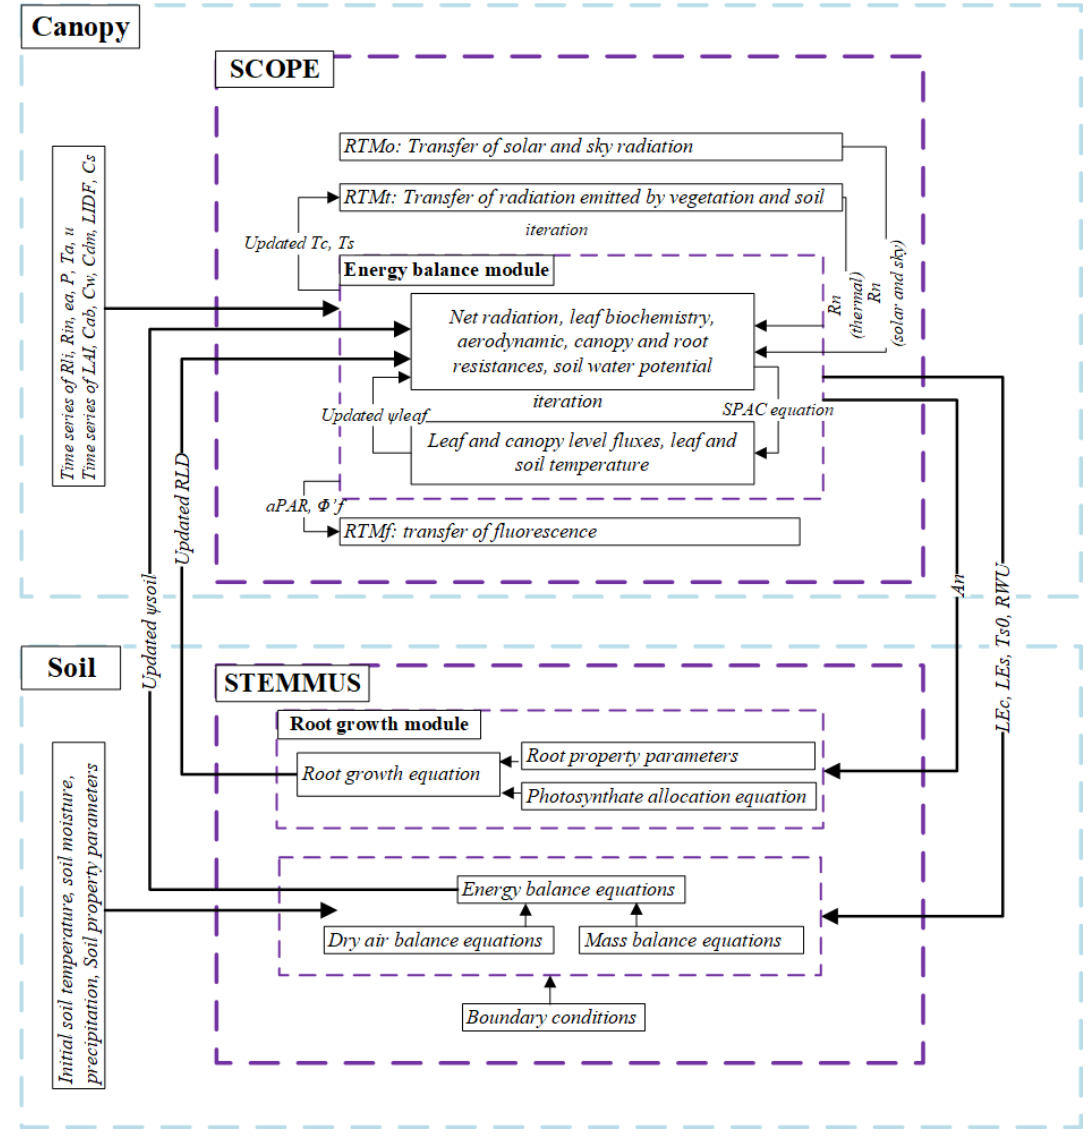
Figure 1. The coupling scheme of STEMMUS–SCOPE. Explanations for the symbols are given in Table B1 in the